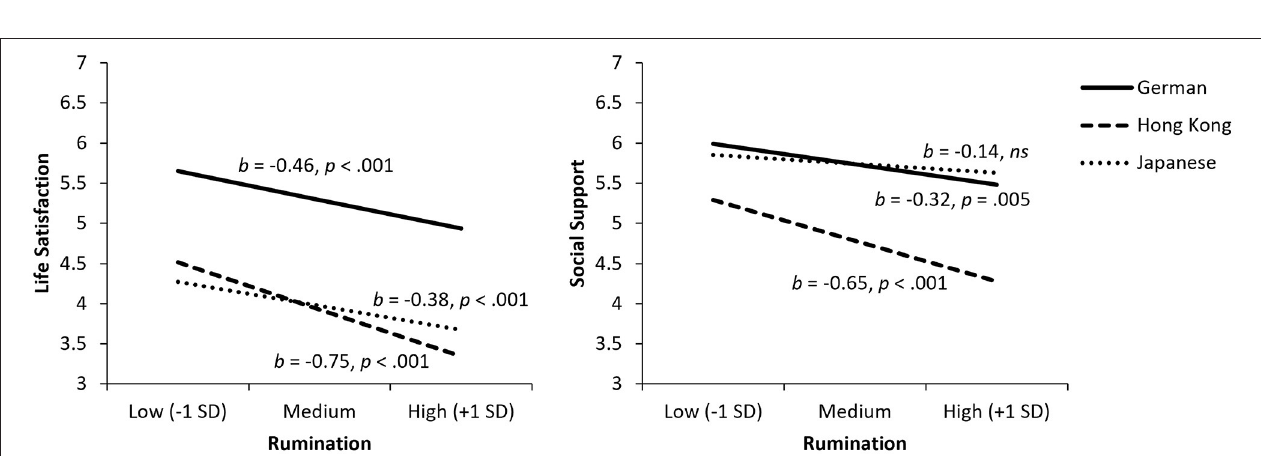
FIGURE 3 | Relationships of rumination with life satisfaction (left) and social support (right). ns, not statistically significant.